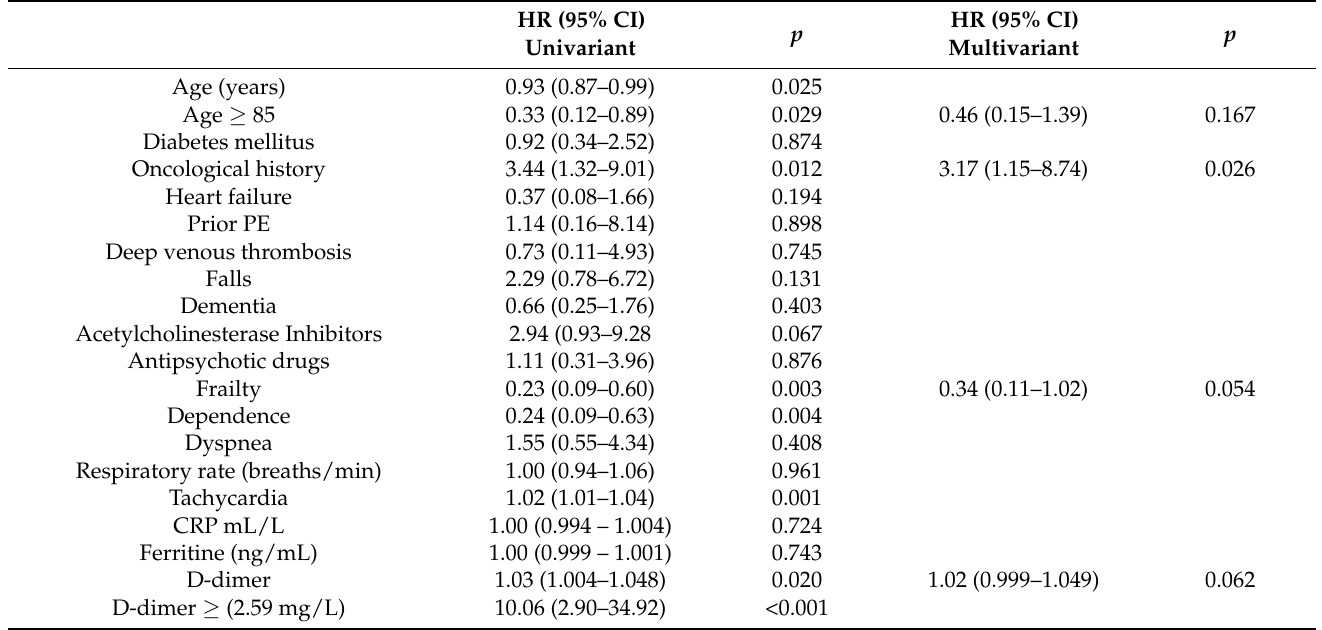
Table 2. Univariate and multivariate analysis of our study